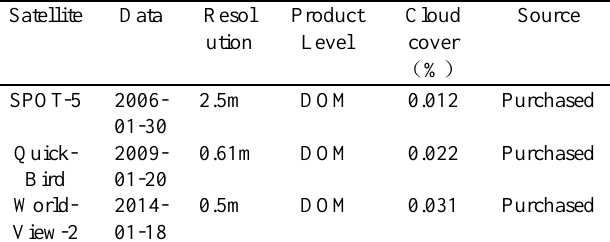
Table 1. Details of satellite